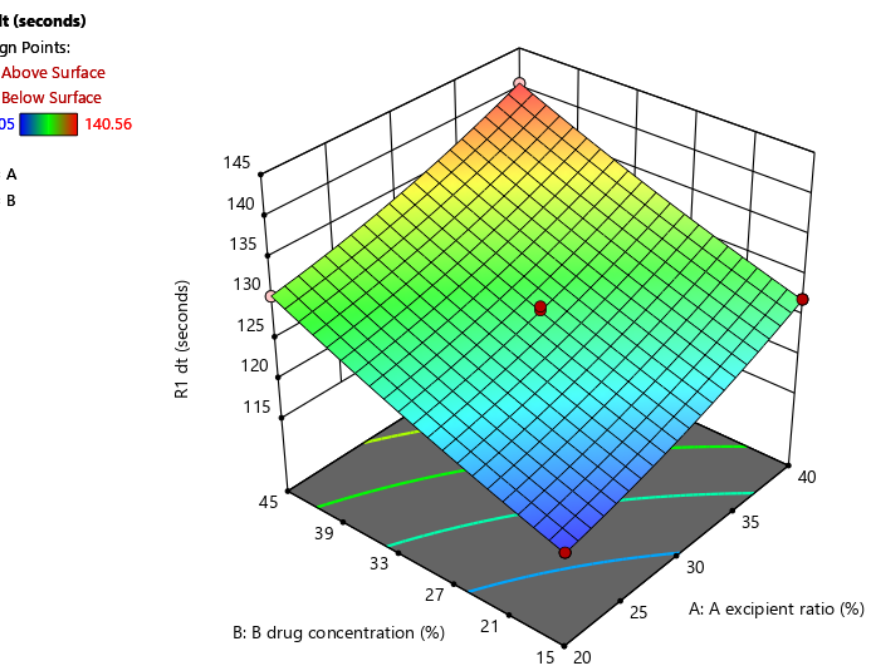
Figure 2. Surface response graph of disintegration time of liquisolid compacts.